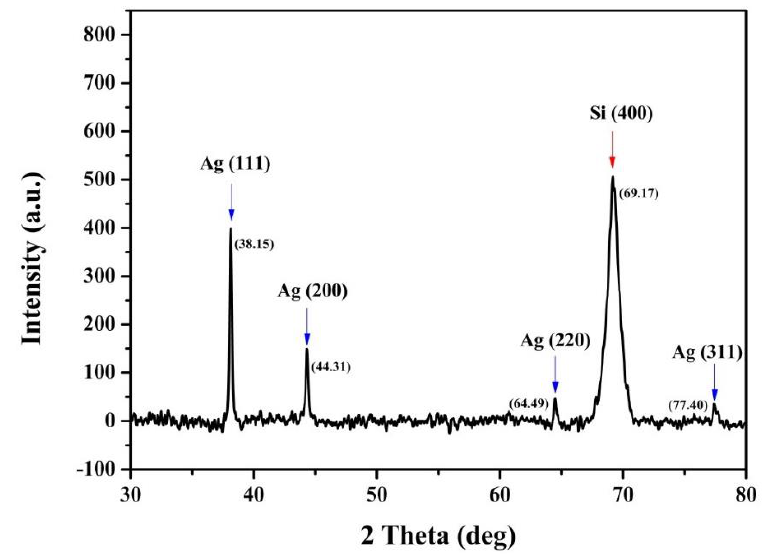
Figure 3. X − ray diffractogram of Ag-NPs on a silicon substrate.